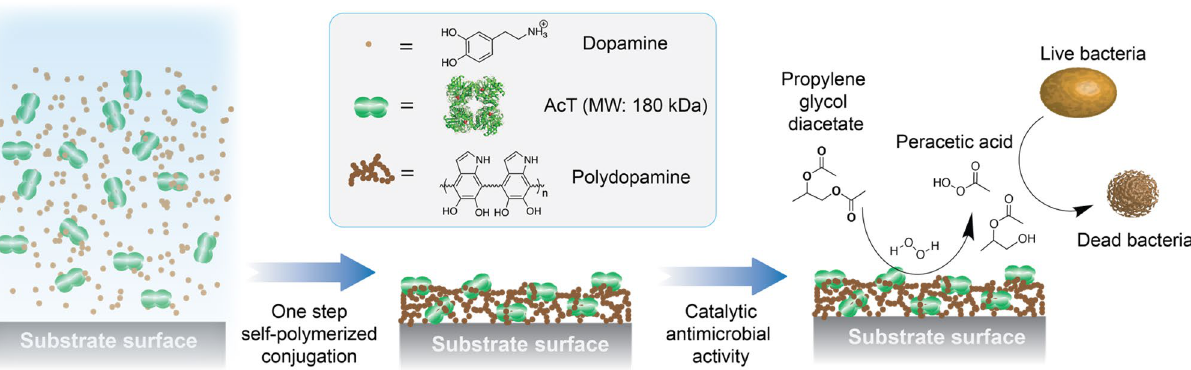
Figure 1. Schematic illustration of single-step fabrication of AcT-polydopamine composite coatings. Incorporation of AcT into polydopamine on a flat surface, via entrapment and/or covalent reaction with the polymer matrix, leads to a stable enzyme-polymer composite coating. The enzymatic reaction of AcT with propylene glycol diacetate and hydrogen peroxide to give peracetic acid is shown, leading to antimicrobial